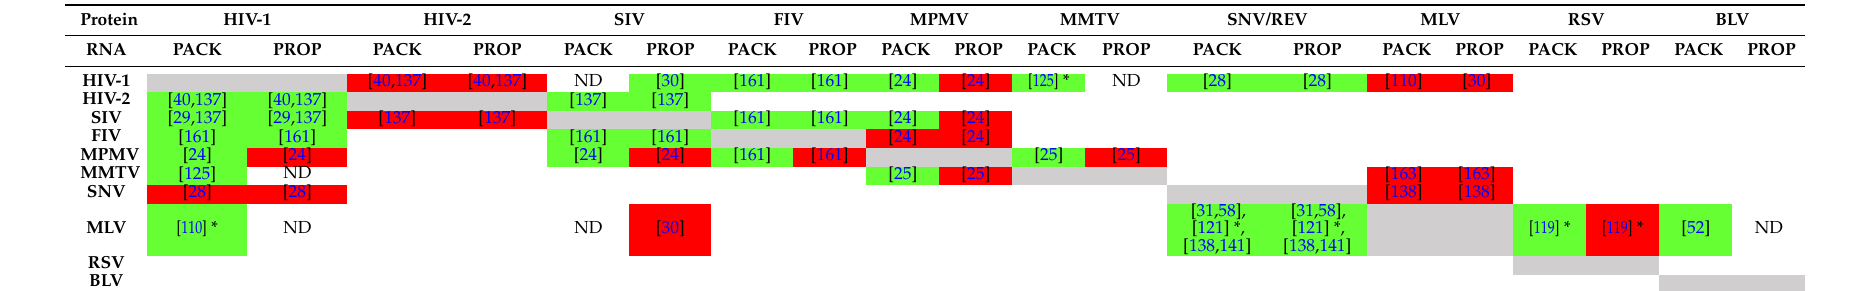
Table 2. Summary of RNA cross-/co-packaging and propagation among